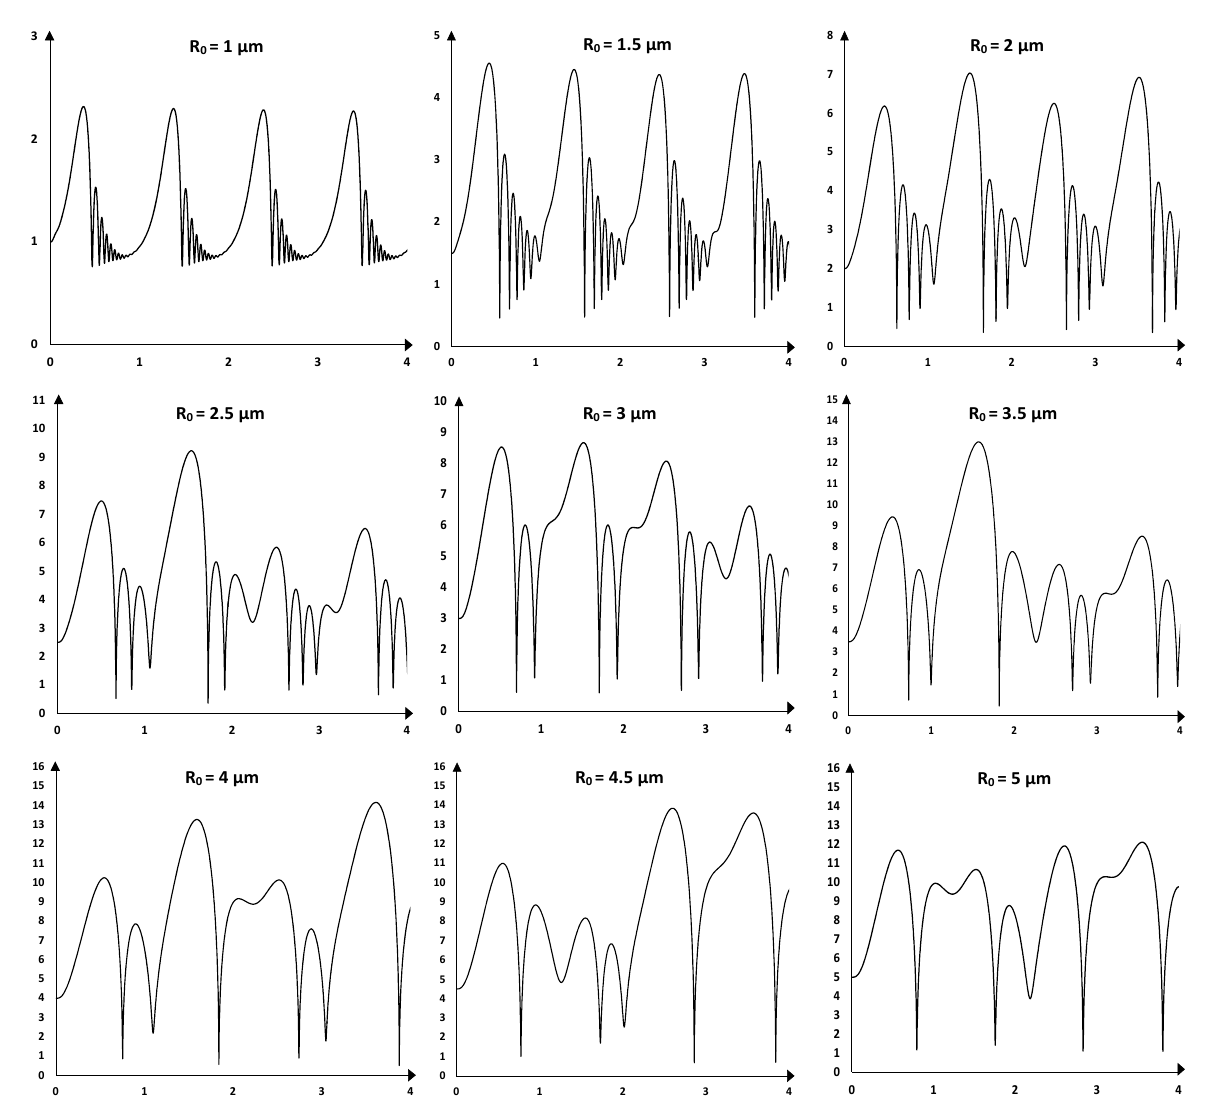
Figure 3. Simulated bubble radius (vertical axis in µm) over four acoustic cycles (horizontal axis) for acoustic bubbles of ambient radii varying in the range 1–5 µm under an exciting wave of 300 kHz and 1.5 atm. The bubbles are supposed to oscillate in water under oxygen–atmosphere.